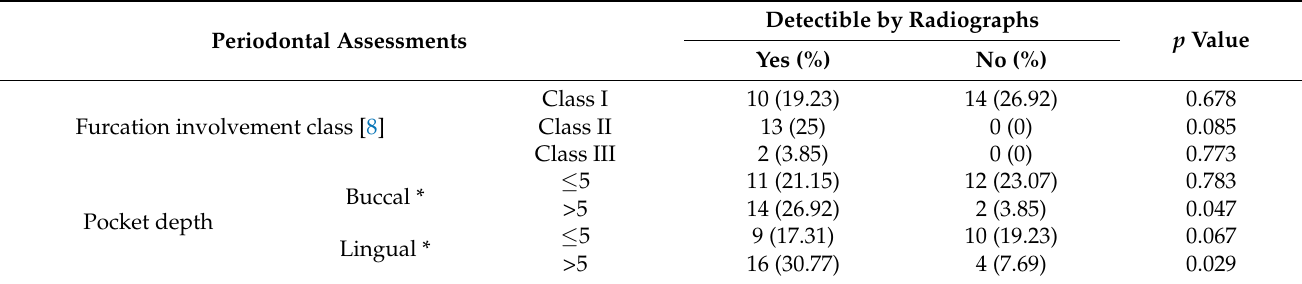
Table 4. Relation between the Class of furcation and other periodontal data to the radiographic detectability of furcation for